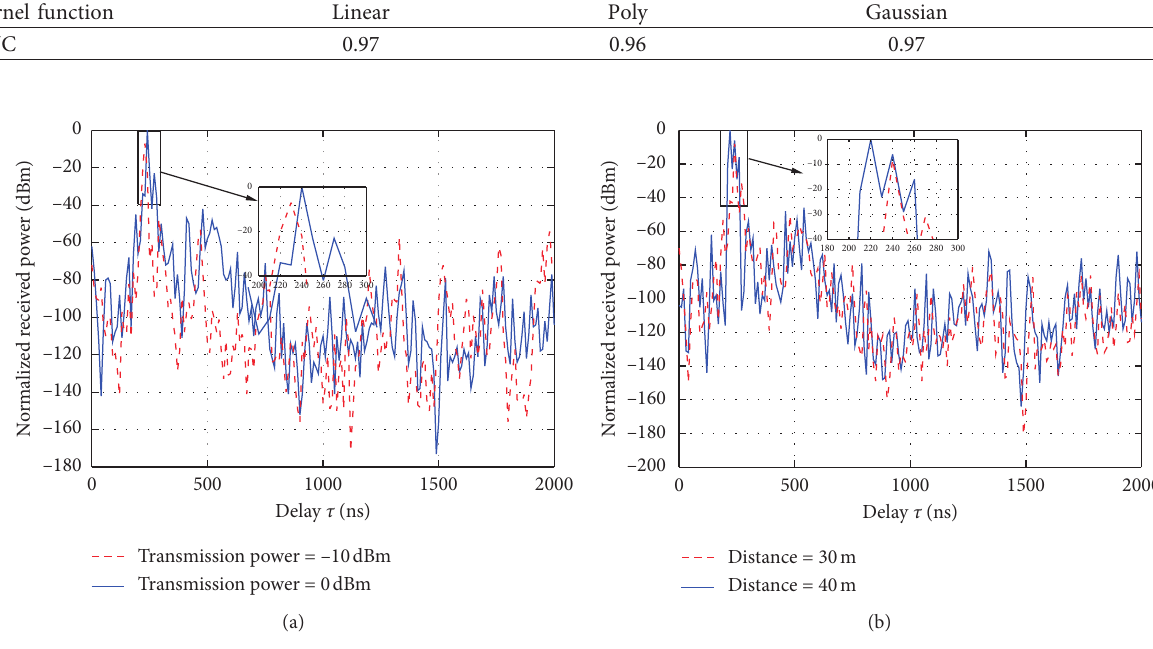
Figure 5: Comparison of PDPs under LOS conditions. (a) Different transmission powers. (b) Different